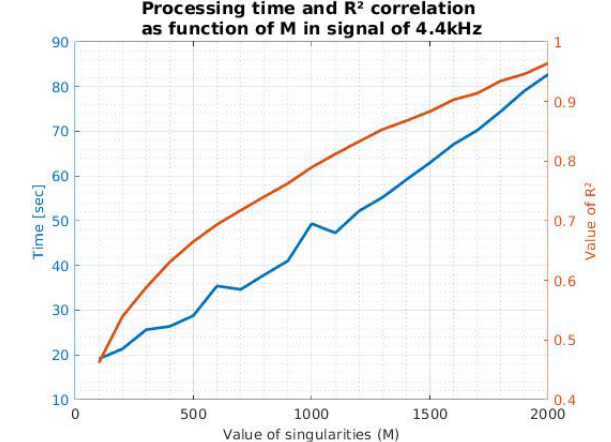
Figure 5. Processing time and correlation coefficient as a function of M, in a bulk carrier ship signal with a sample rate of 4.4